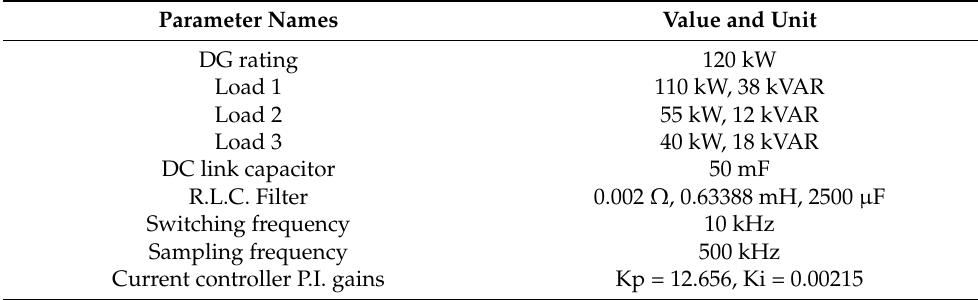
Table 1. Studied M.G. Model Parameters.